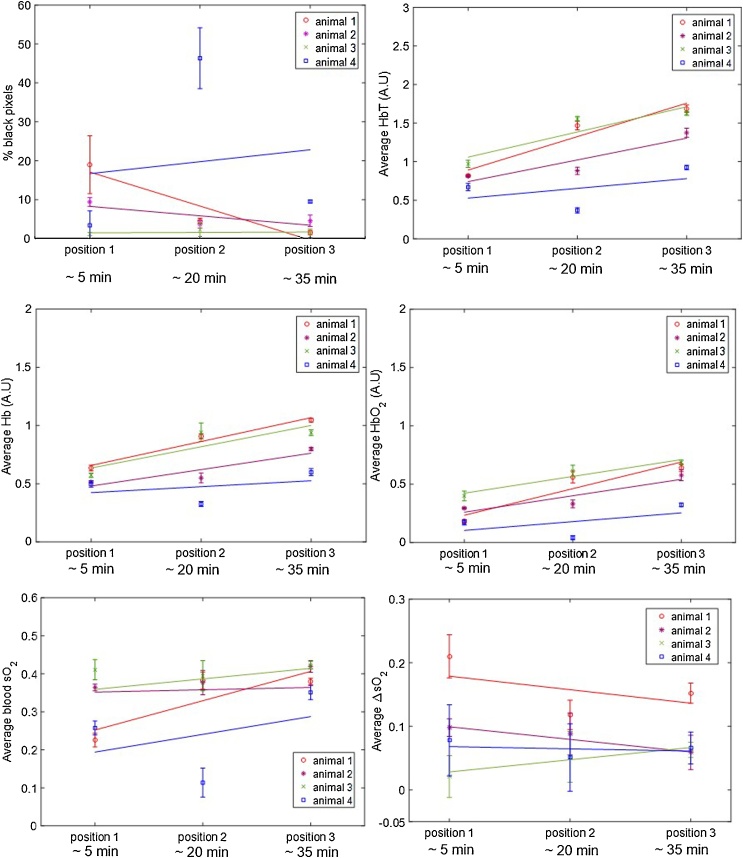
ROI-averaged percentage of black pixel, and Hb, HbO2, HbT, blood sO2 and ΔsO2 signals, for CALR tumours (n = 4) imaged after being removed and re-positioned in the tank three times, during air-breathing. Error bars represent the standard deviation over 3 adjacent central tumour slices, 1 mm apart. Solid lines represent a linear regression fitted to the data.